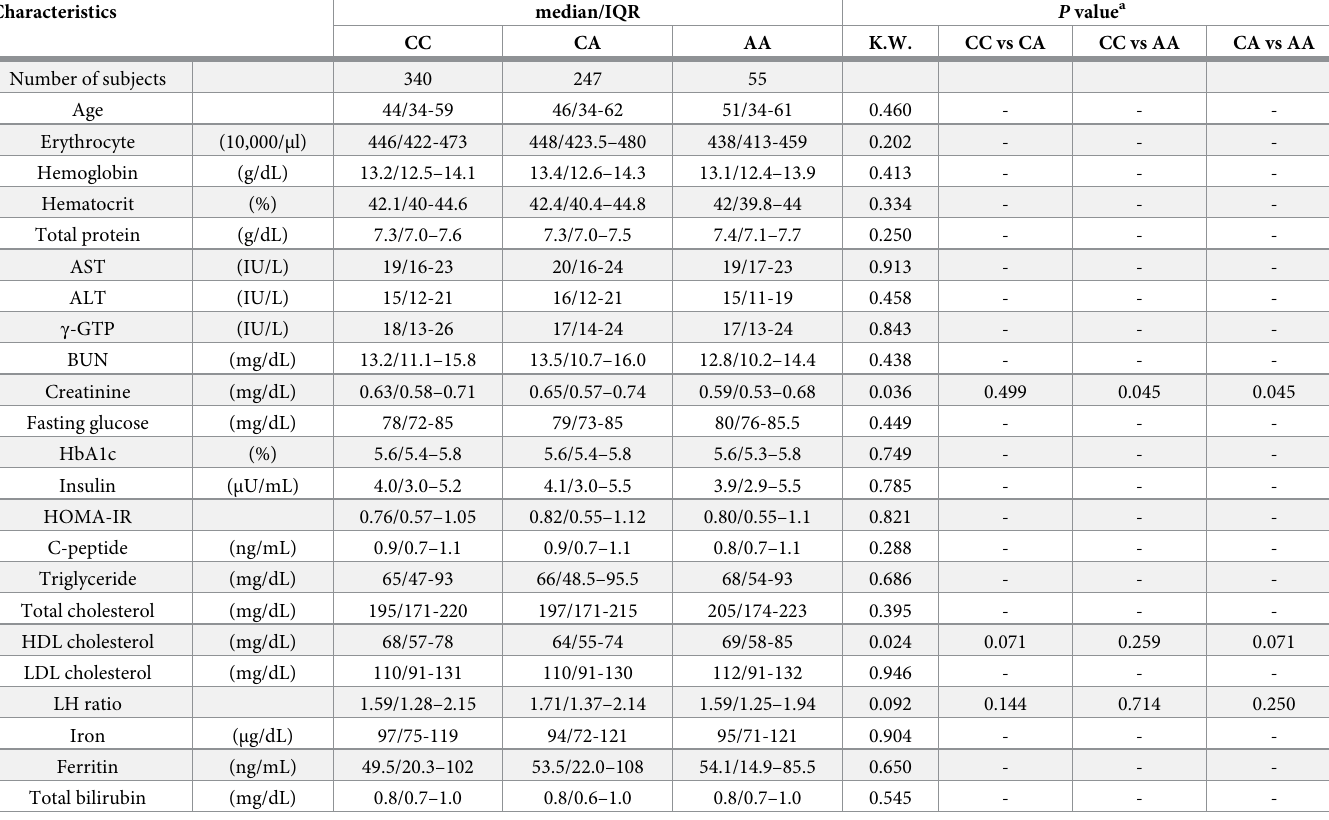
Table 2. The median and IQR of general characteristics in never-smoking healthy subjects.